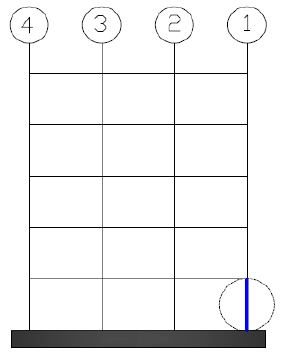
Fig. 23. Schematic of column for analyzing bending